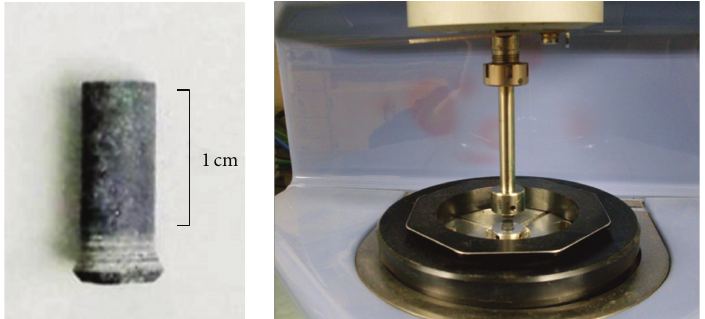
Figure 2: Column aggregate sample and setup of sample.